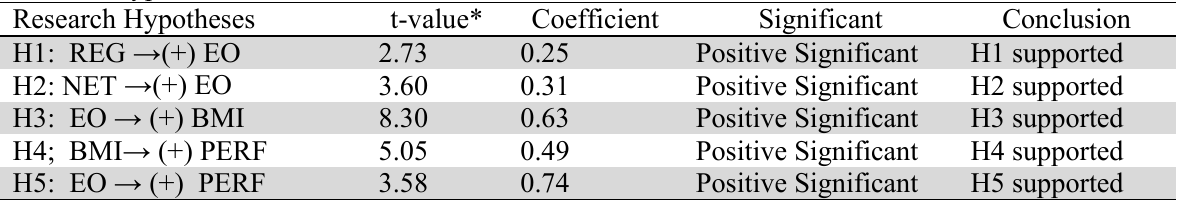
Research Hypotheses Test Results Research